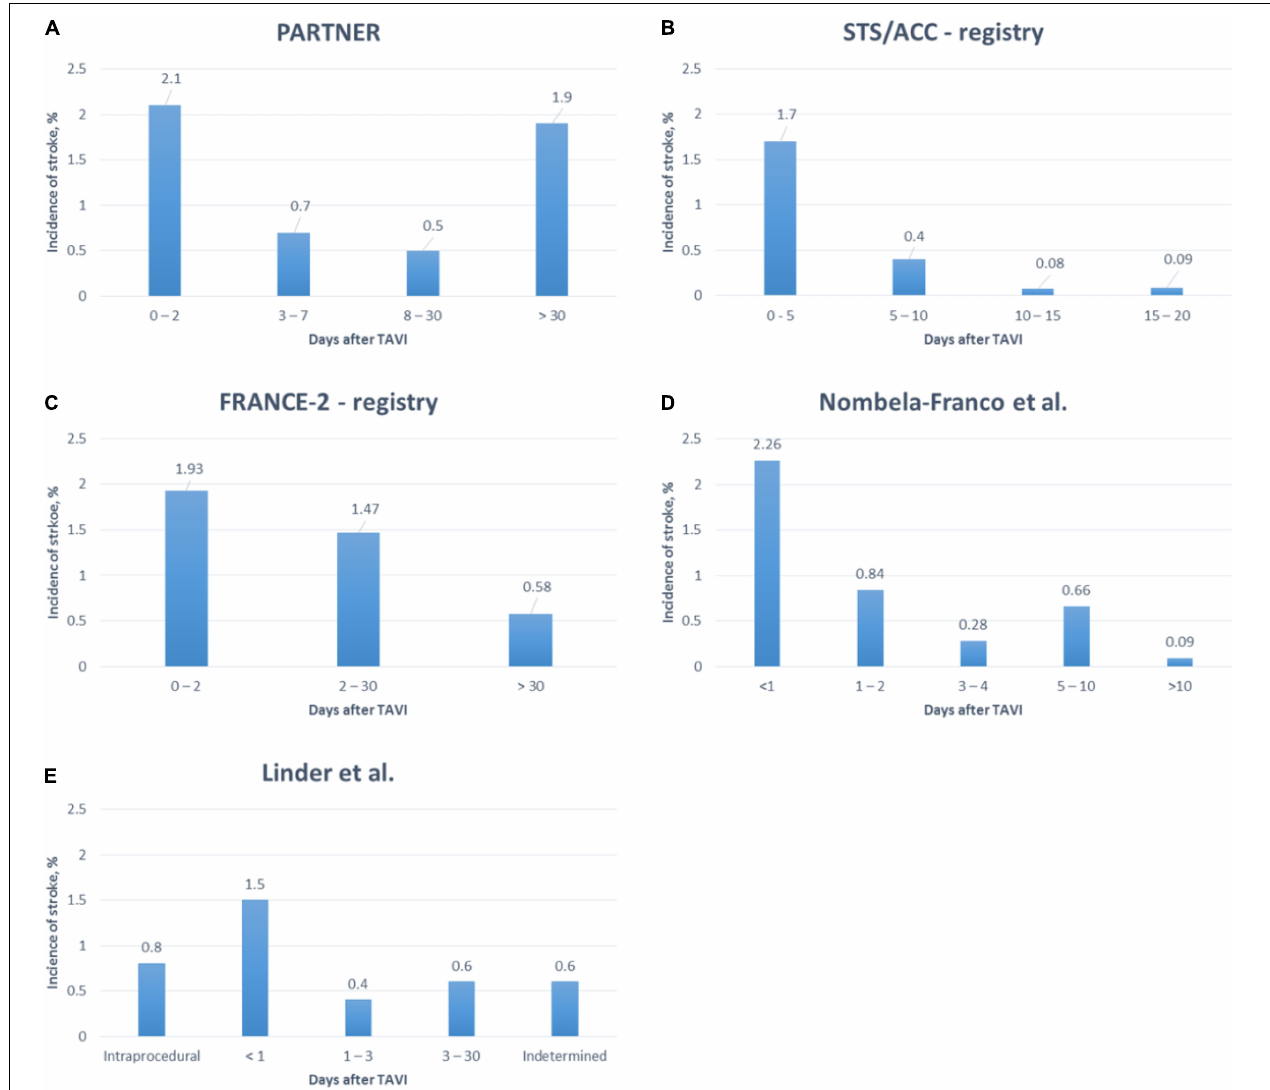
FIGURE 3 | Timing of stroke after TAVI in a randomized controlled trial (18) and several registries (9,